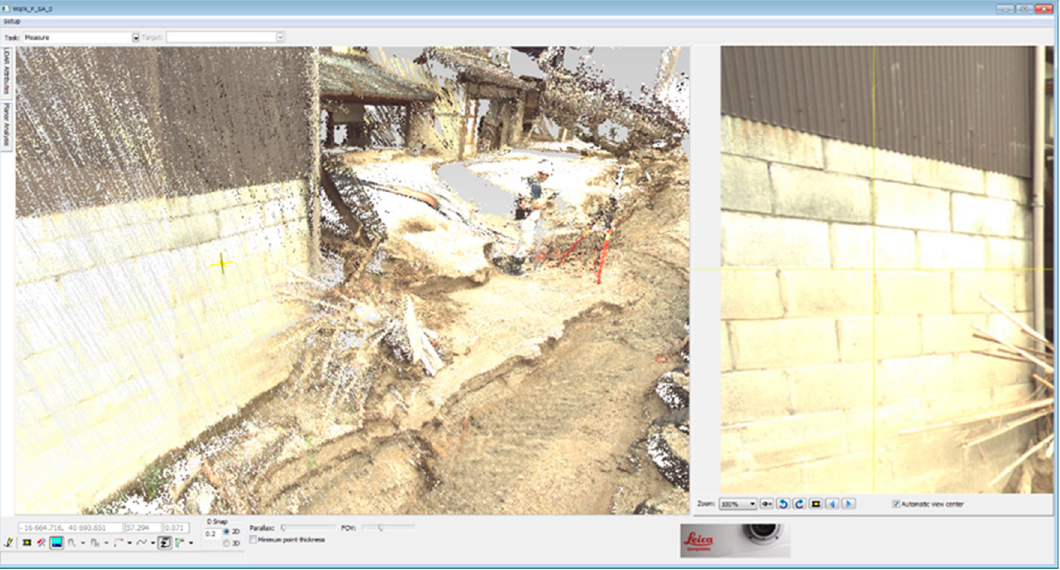
Figure 8. Flood traces on sidewall of building.